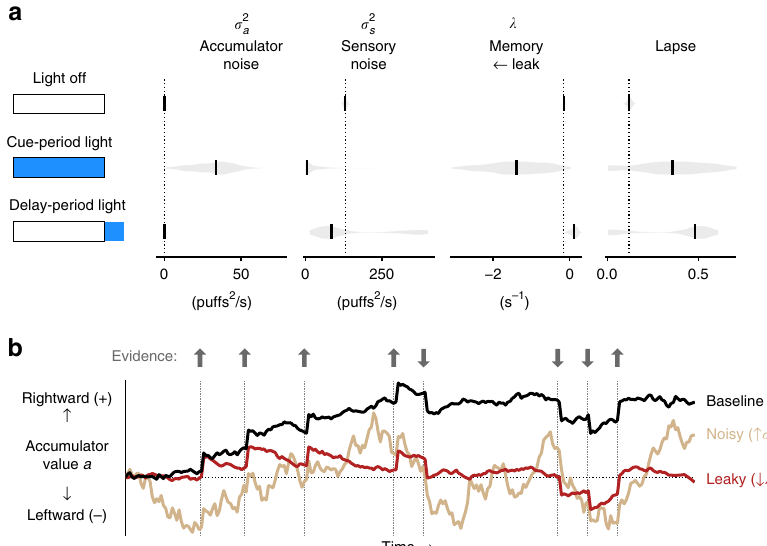
Fig. 3 Fits to a drift-diffusion model reveal speci fi c de fi cits in evidence accumulation. a Best- fi t drift-diffusion model parameters in different light delivery conditions (schematics on left indicate light delivery condition, with the box denoting the cue period and blue shading denoting light delivery). Fits were computed multiple times for each condition using random subsets of the data to assess the reliability of the best- fi t parameters (see Methods). Black vertical ticks indicate the median best- fi t parameter across fi t repetitions. Gray shading represents the distribution of fi t parameters across repetitions. Vertical dotted lines denote best- fi t values in the light-off condition. b Visualization of the drift-diffusion model. The model's accumulator value a is shown as it evolves over time in a single behavioral trial. Colored lines demonstrate how the trajectory of a is qualitatively altered by changes in speci fi c parameters. Arrows and associated vertical lines indicate pulses of evidence. See also Supplementary Movie